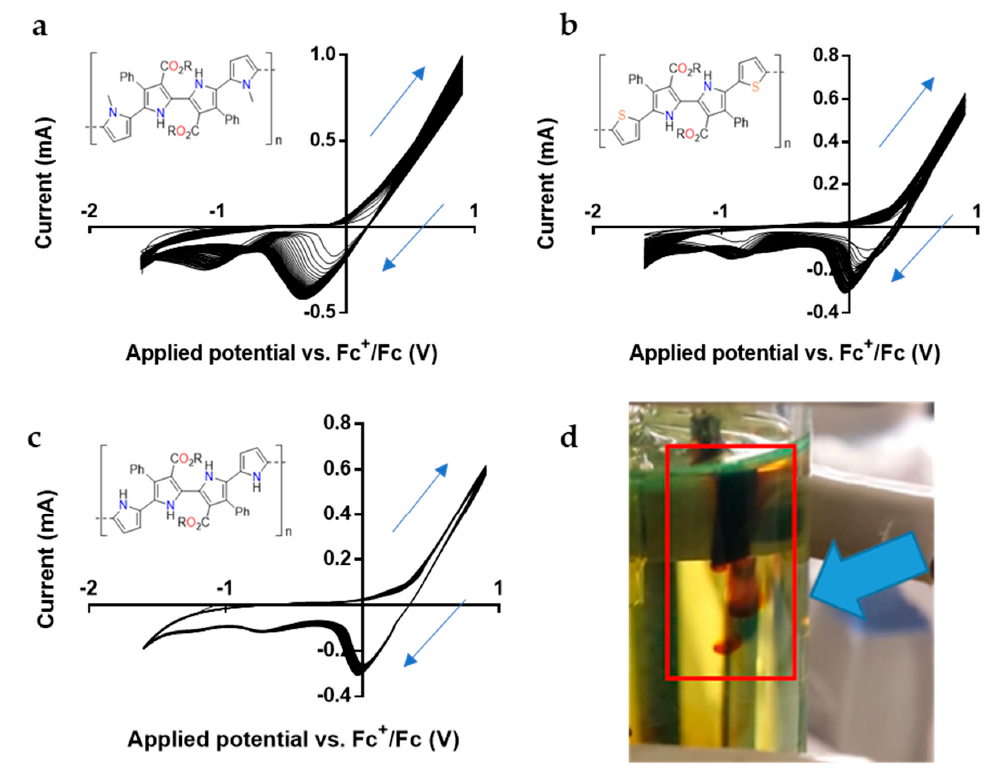
Figure 3. Cyclic voltammograms of 2,2’–bipyrrole monomers in THF (10 mM) + 0.1 M TBAP. The voltammograms correspond to 1b ( a ), 1c ( b ), and 1a ( c ). Working electrode during quaterpyrrole electropolymerization ( d ) (R = Et).